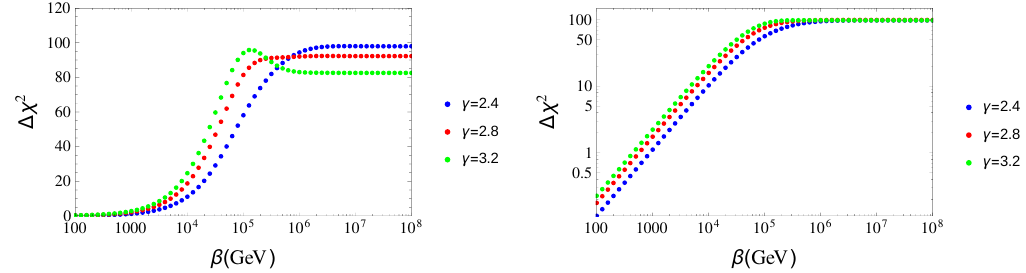
Figure 7 . (cid:1) (cid:31) 2 with (cid:12) for di(cid:11)erent steepness of the neutrino (cid:13)ux ( (cid:13) = 2 : 4 ; 2 : 8 ; 3 : 2) for initial (cid:13)ux amplitude a. (cid:8) 0 = 5 (cid:2) 10 (cid:0) 18 (GeV cm 2 s sr) (cid:0) 1 (left) b. (cid:8) 0 astro